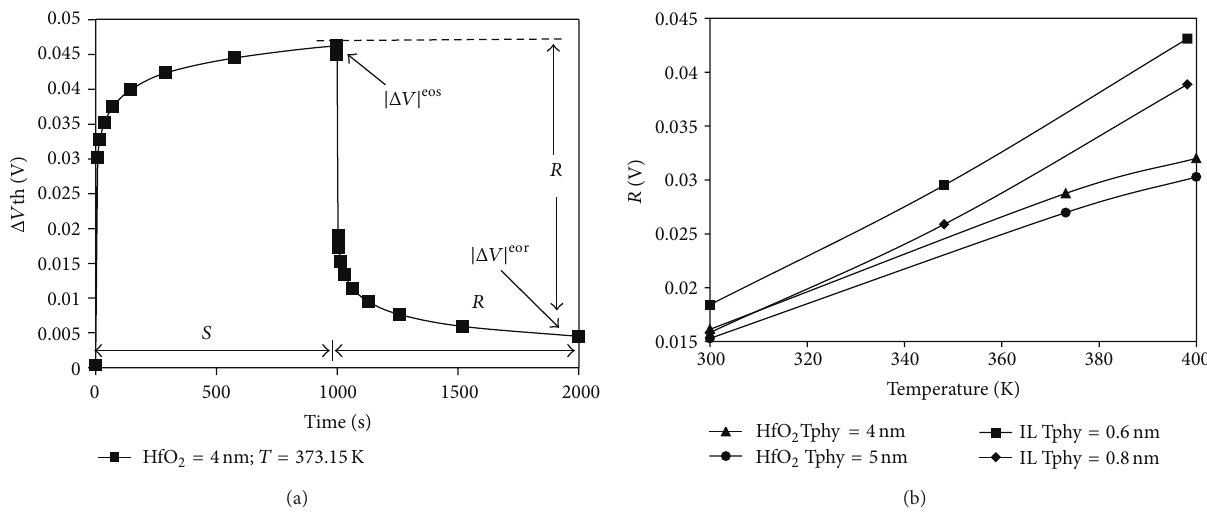
Figure 8: (a) Evolution of Δ𝑉 th and definition of recovery component, 𝑅 , in a typical dynamic NBTI cycle and (b) 𝑅 as a function of stress